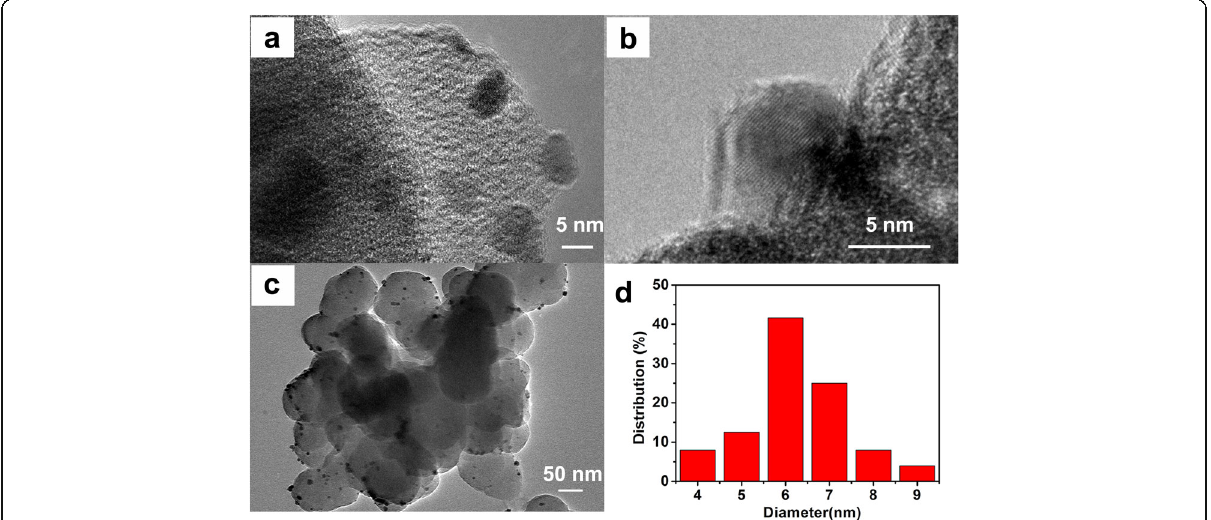
Fig. 2 a The TEM patterns and b the HRTEM patterns of Pd/MOF 3% sample. c , d The size distribution for Pd NPs of Pd/MOF 3%